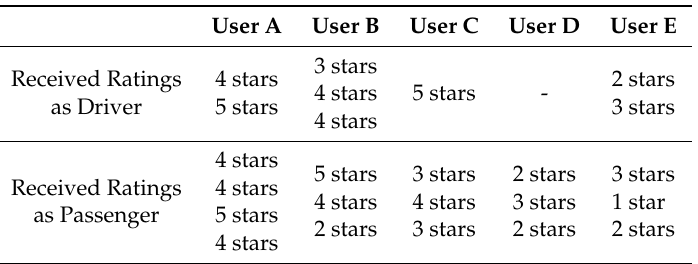
Table 5. Example of Received Ratings.